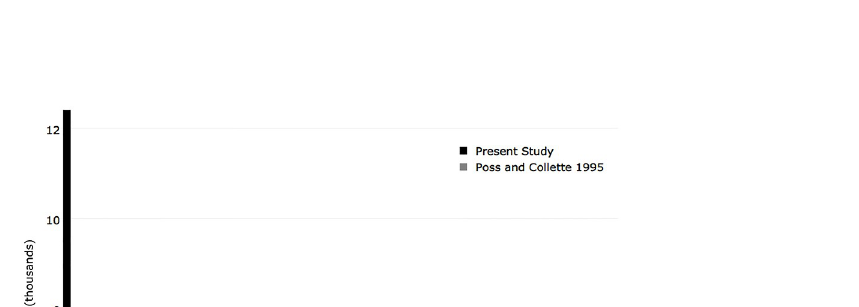
Fig 11. Comparison of the number of primary type records currently published in iDigBio (black) with the number reported in Poss and Collette (1995) (grey).